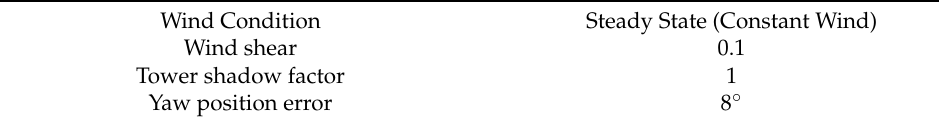
Table 2. Ultimate load analysis condition.